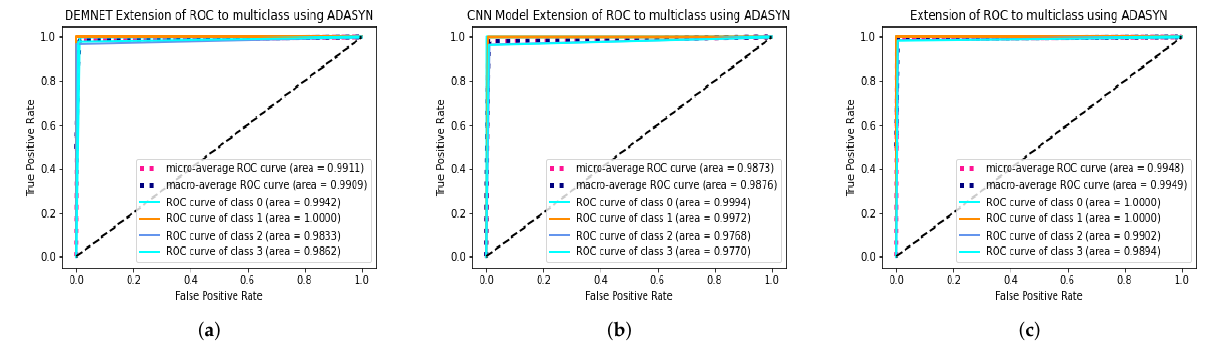
Figure 13. Extension Receiver results of DEMNET, CNN Model, and DAD-Net using ADASYN. ( a ) DEMNET; ( b ) CNN Model; ( c ) Proposed